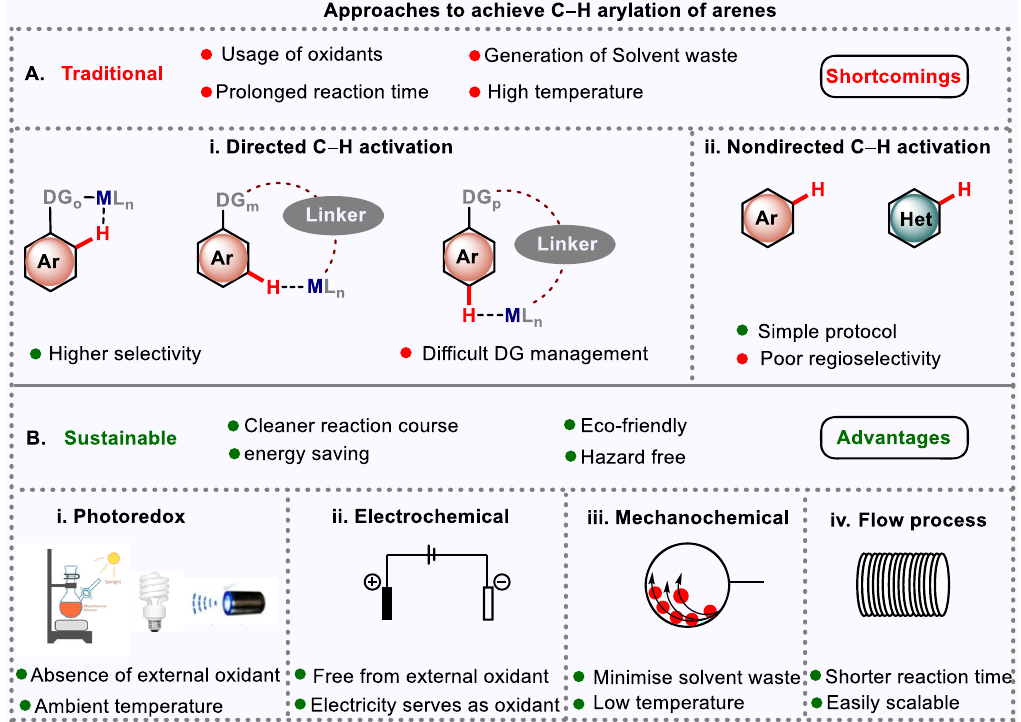
Fig. 1 Approaches for site-selective C – H arylation. A Traditional approaches of C – H arylation of arenes. B Sustainable approaches of C – H arylation of